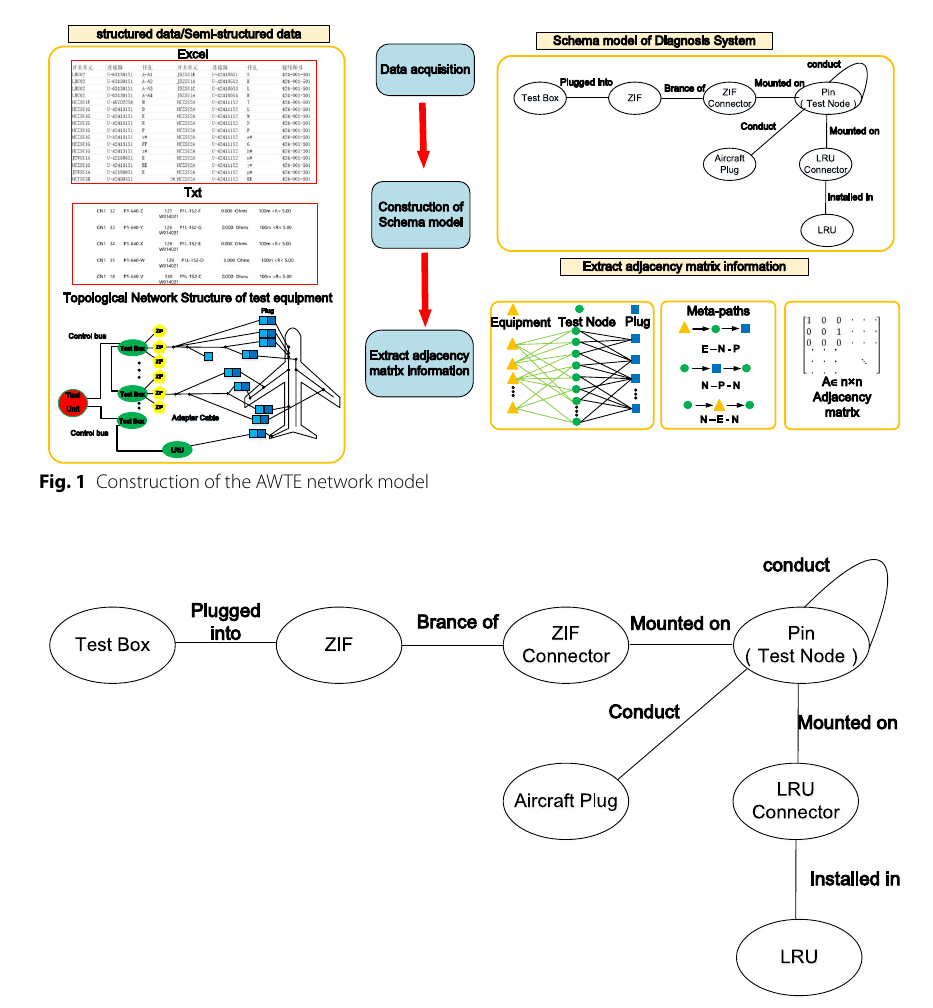
Fig. 2 Schema model of test equipment for aircraft wiring